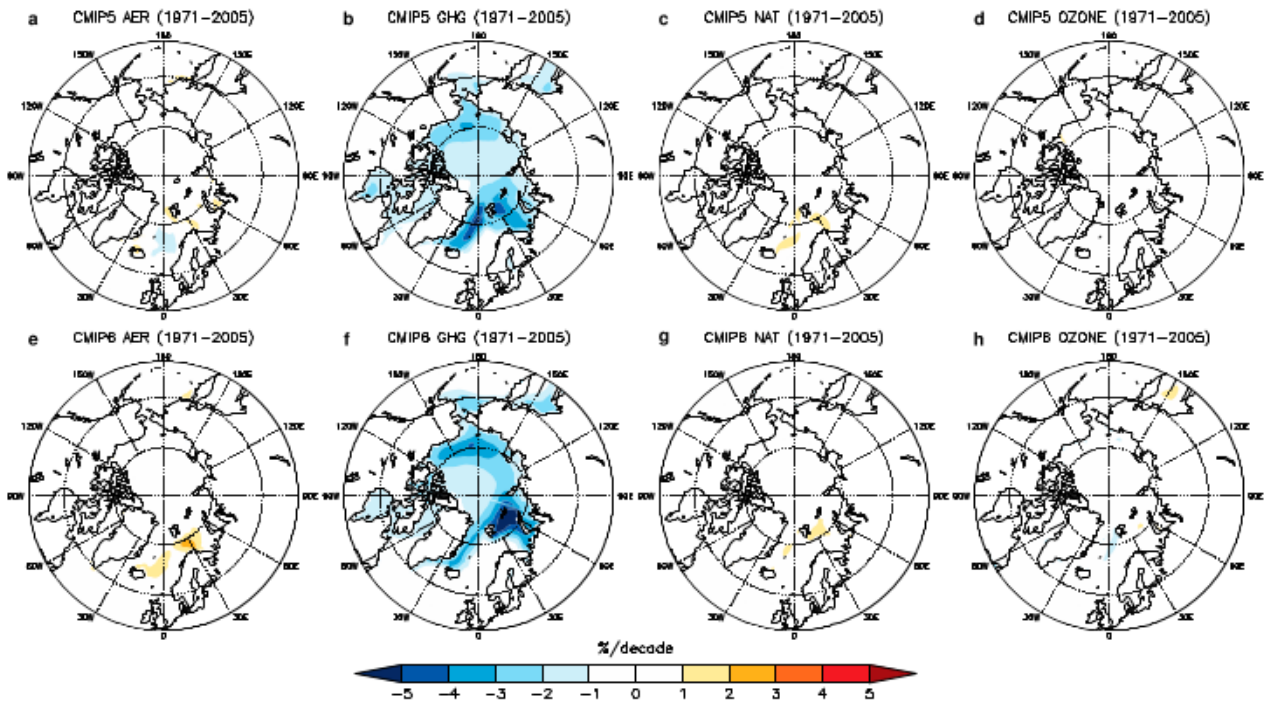
Figure 6. ( a – d ) Linear trends of annual mean sea ice concentrations (shading in percent/decade) for the MMMs of CMIP5 ( a ) AER, ( b ) GHG, ( c ) NAT, and ( d ) OZONE simulations during 1971–2005. ( e – h ) Same as ( a – d ) but for CMIP6